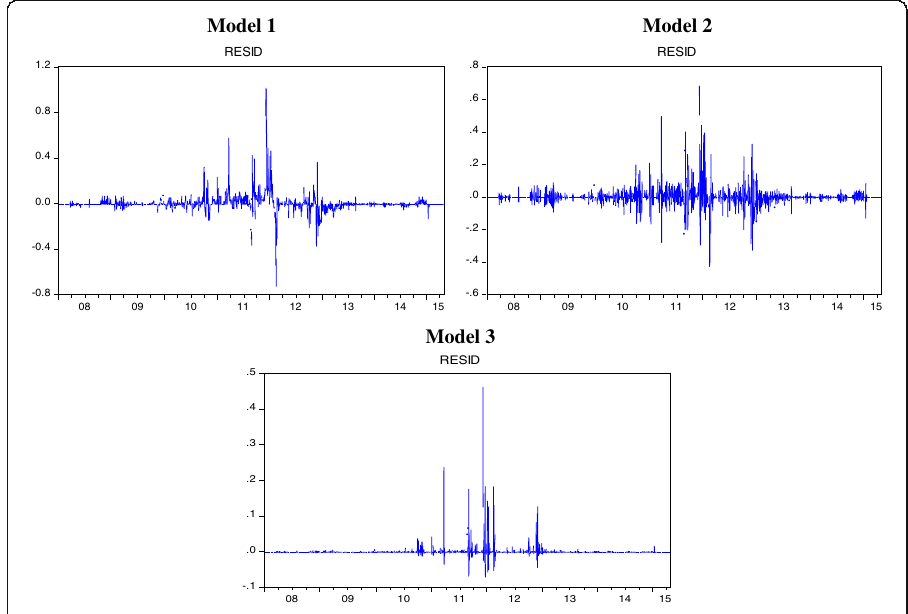
Fig. 2 Volatility clustering of Taka/US dollar exchange rate return